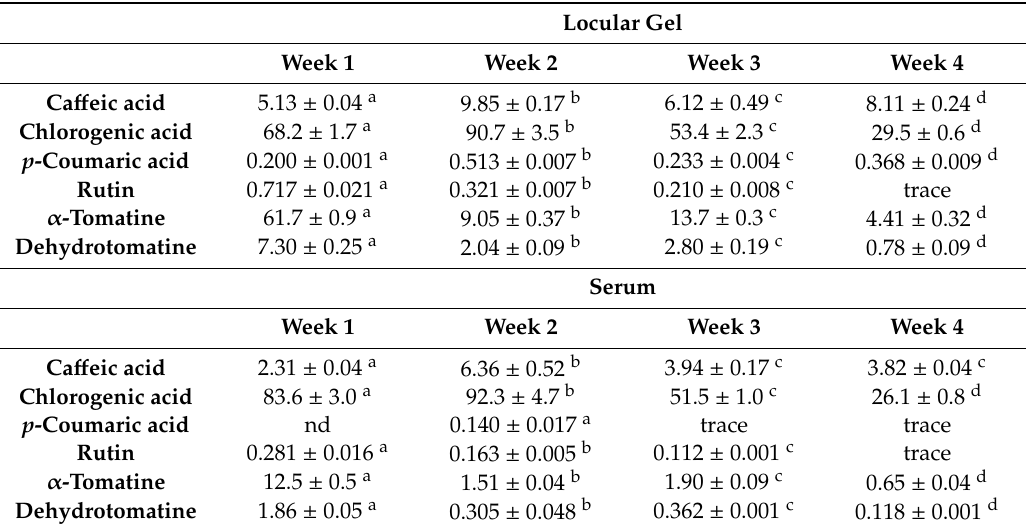
Table 1. Polyphenols and glycoalkaloids content in gel and serum from Camone tomatoes sampled in four different weeks.